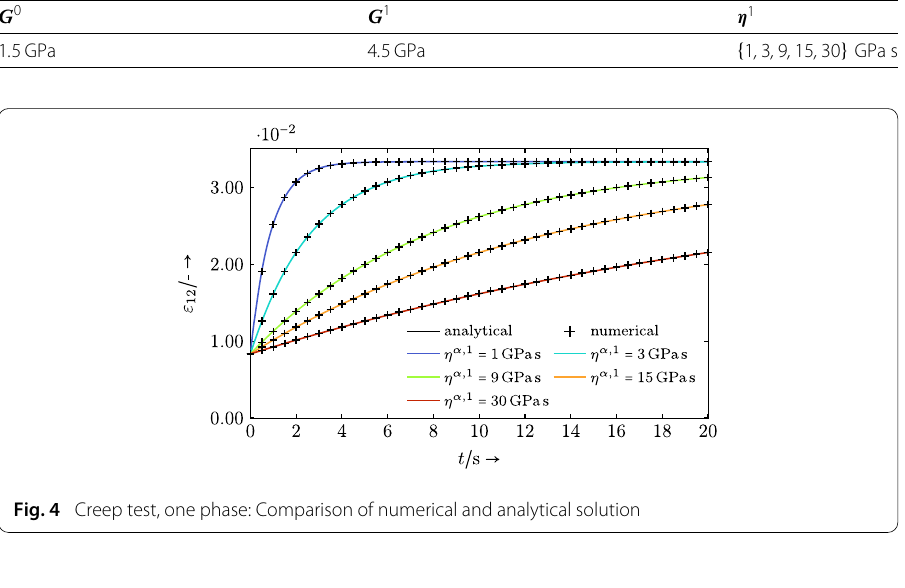
Table 2 Creep test: Material properties G 0 G 1